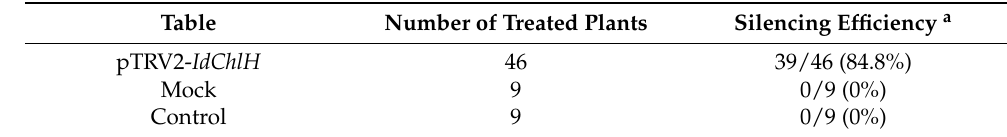
Table 2. Silencing efficiency of IdChlH in I. dabieshanensis using TRV-based VIGS system at 21 dpi. Table Number of Treated Plants